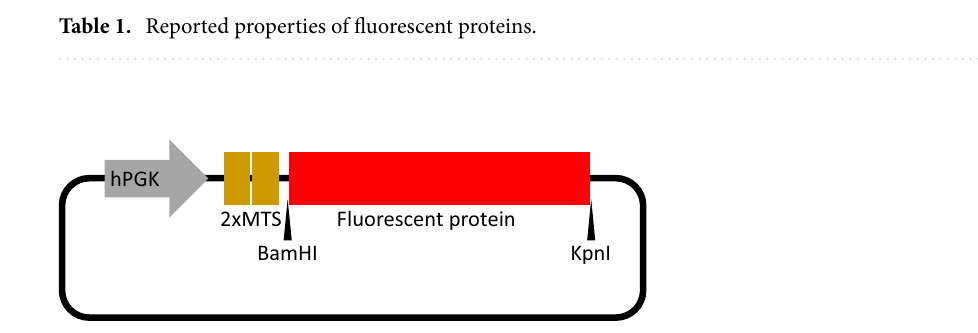
Figure 1. Scheme of a mitochondria-targeted fluorescent protein expression vector. The selected fluorescent protein genes were inserted between BamHI and KpnI restriction enzyme sites of pLKO-based backbone, each preceded by a human phosphoglycerate kinase (hPGK) promoter and a tandem mitochondrial targeting signal (MTS) of the human COX8A